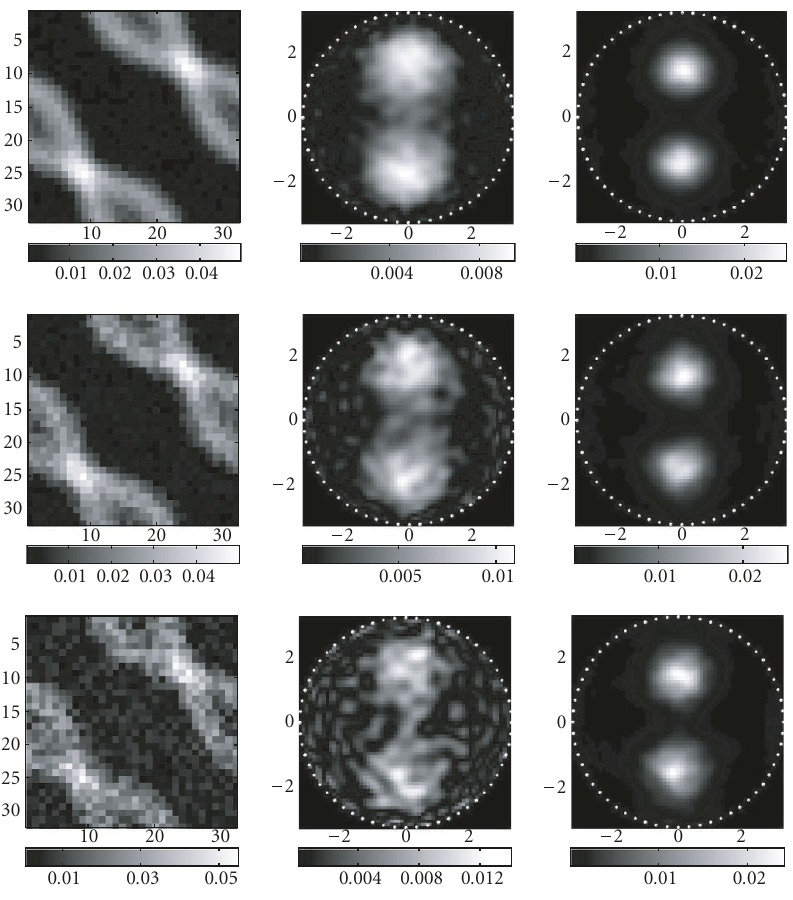
Figure 8: Noisy sinograms (left), blurred tomograms (center), and restorations by unpreconditioned MRNSD (right): phantom with two inhomogeneities of diameter 1 . 4 cm. The noise level from top to bottom is equal to 5, 10, and 20%.